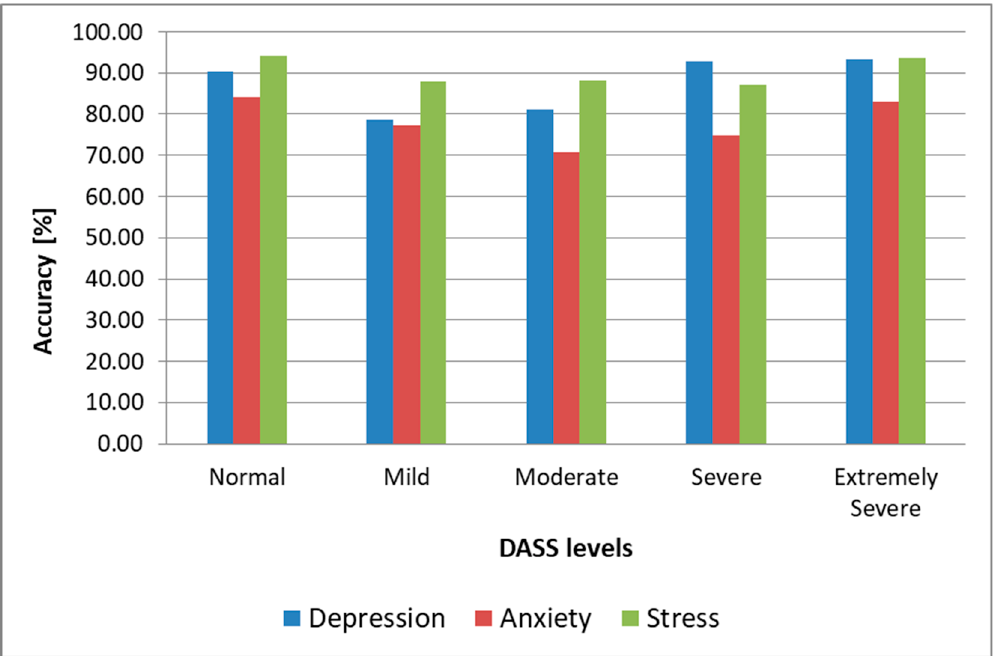
Figure 10. DASS levels prediction accuracy (intrasubject methodology).